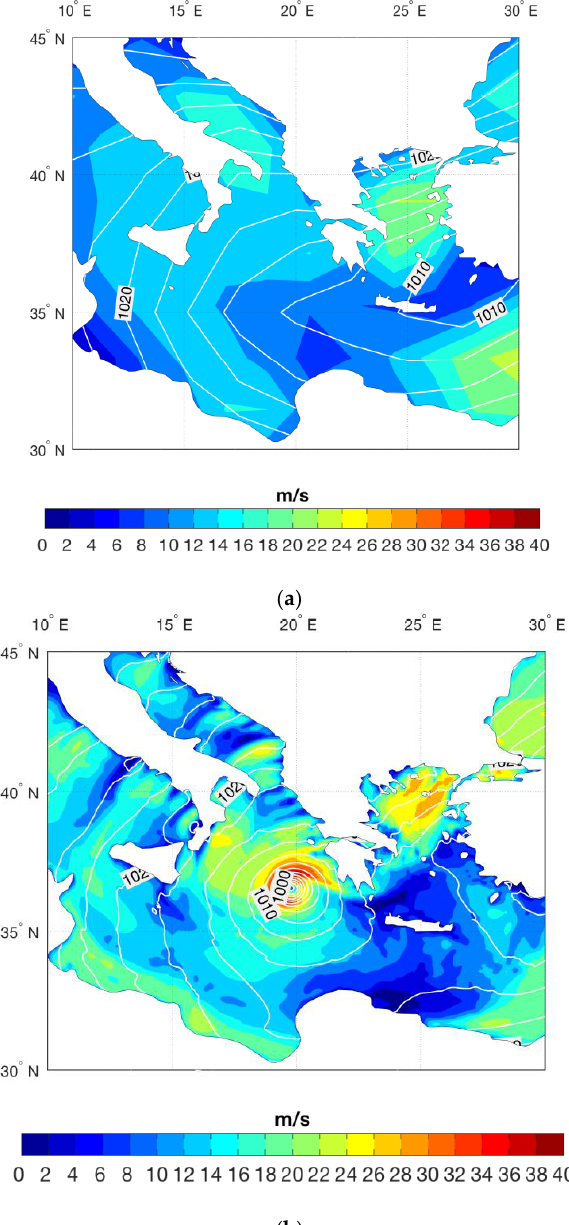
Figure 3. Snapshots of January 1995 Medicane on 15 January at 18 UTC. ( a ) Sea level pressure (2 hPa contours) and wind field (m/s, color shaded) from the forcing NCEP reanalysis. ( b ) Same as ( a ) but from COSMO-CLM simulation at 10 km